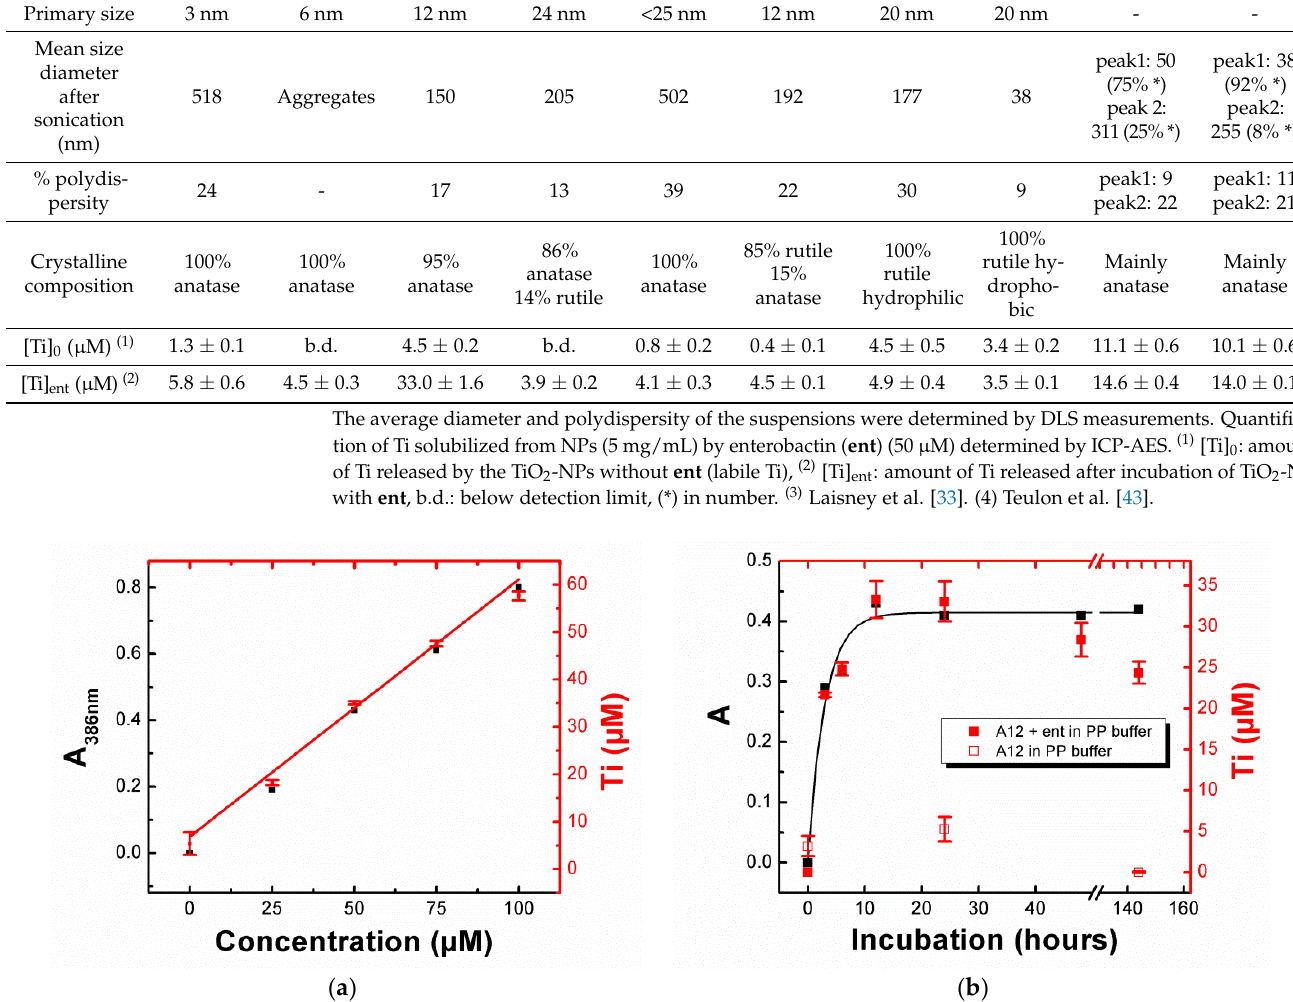
Table 1. Physicochemical characteristics of the TiO 2 -NPs and their solubilization by enterobactin.